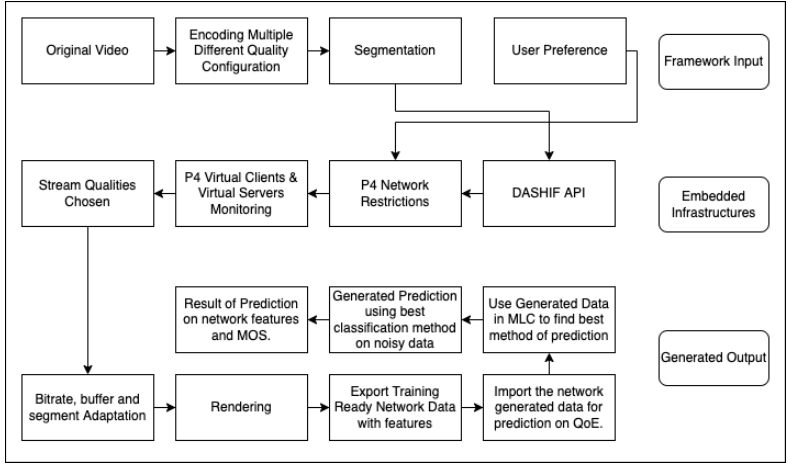
Figure 1. Proposed experimental framework for feature evaluation. Table 2. Video database encoding